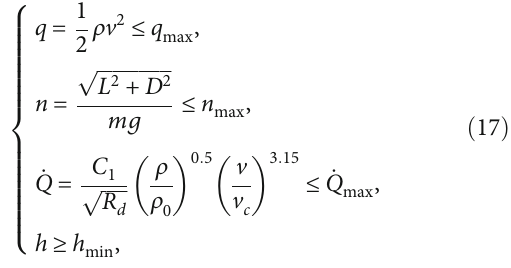
ffiffiffiffiffiffiffiffiffiffiffiffiffiffiffi